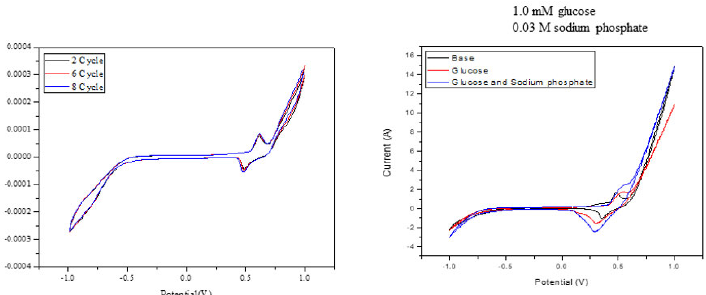
Figure 6. Cyclic voltammograms of the prepared catalytic electrode (No. 4) in 0.1 M NaOH with scan rate 100 mV/min.